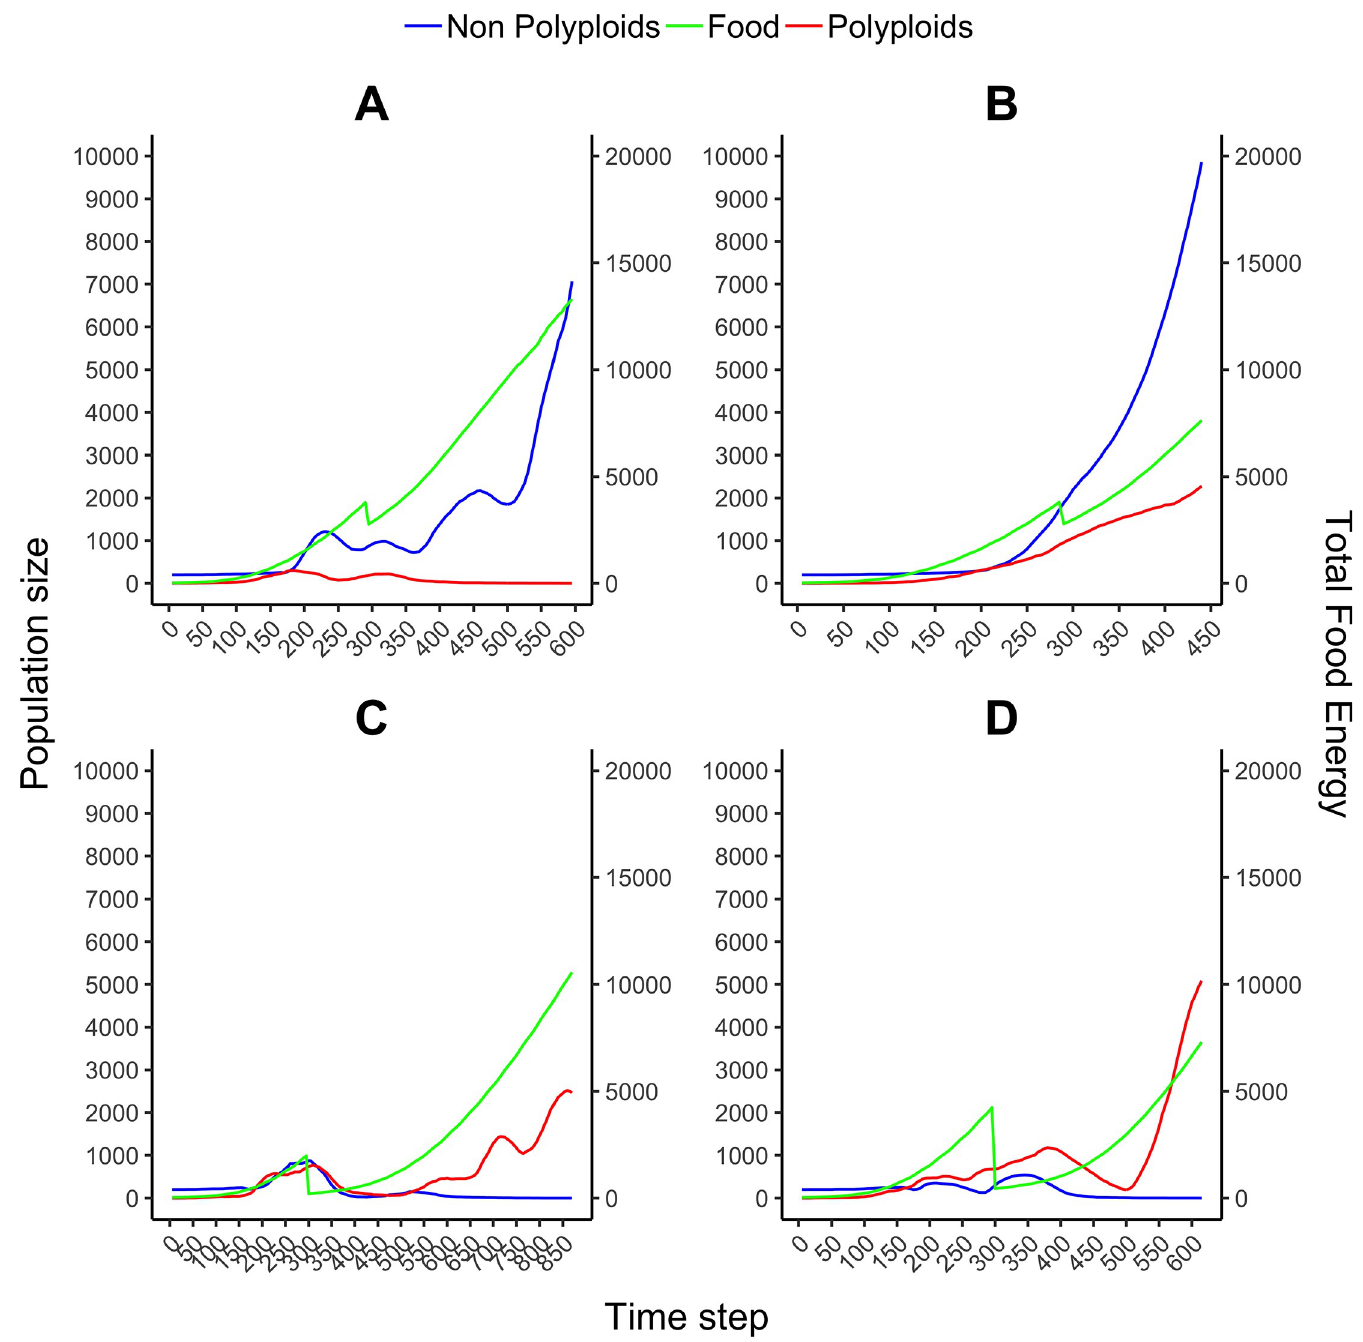
Fig 4. Evolution of population size of polyploids and non-polyploids with respect to food energy availability in four individual experiments under a scenario of fixed food reduction. 30% (A and B) or 90% (C and D), respectively, of the food was removed at time step 300. Simulations start with a population of 200 non-polyploid DOs, which evolve under a WGD rate set at 40%. The WGD rate is removed when the number of polyploids in the population equals the number of non-polyploids (usually at time step 150–200). Simulations were run for up to 1000 time steps, or until either the polyploid or non-polyploid subpopulations become extinct or start growing exponentially (imposing computational